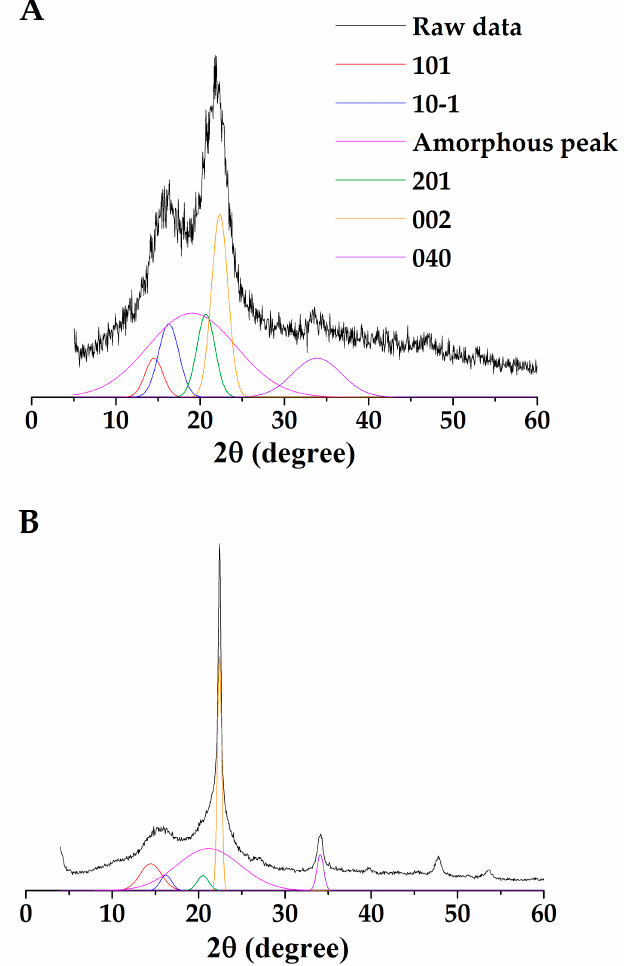
Figure 5. XRD diffractograms of the starting raw Arundo donax L. ( A ) and the CRR recovered from run 13 ( B ).